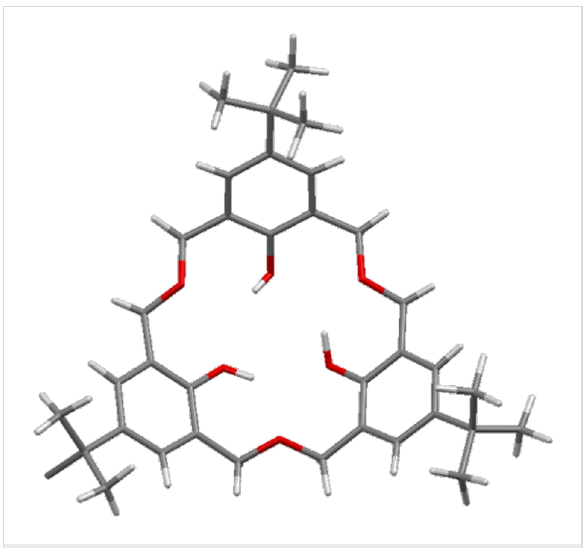
Figure 4: X-ray crystal structure of 3a showing phenolic hydrogen bonding (IUCr ID AS0508)